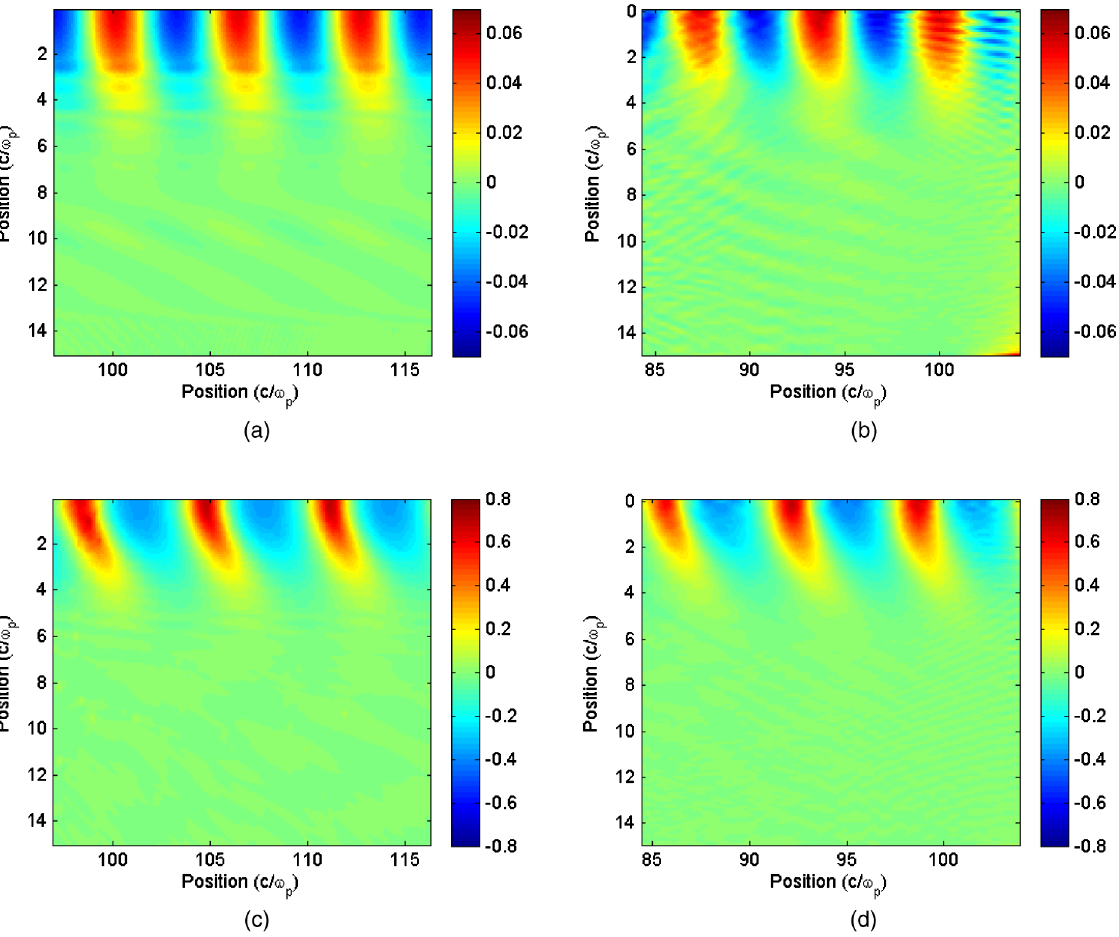
FIG. 3. Shape of the electron density modulation profile as a function of position (a) obtained directly from the simulation results and (b) calculated from the probe ’ s frequency profile for a linear wakefield and (c) – (d) for a nonlinear wakefield. The distortion at the front and at the back on (d) is because the intensity of the pulse at that point is low, hence reduces the accuracy of the retrieved